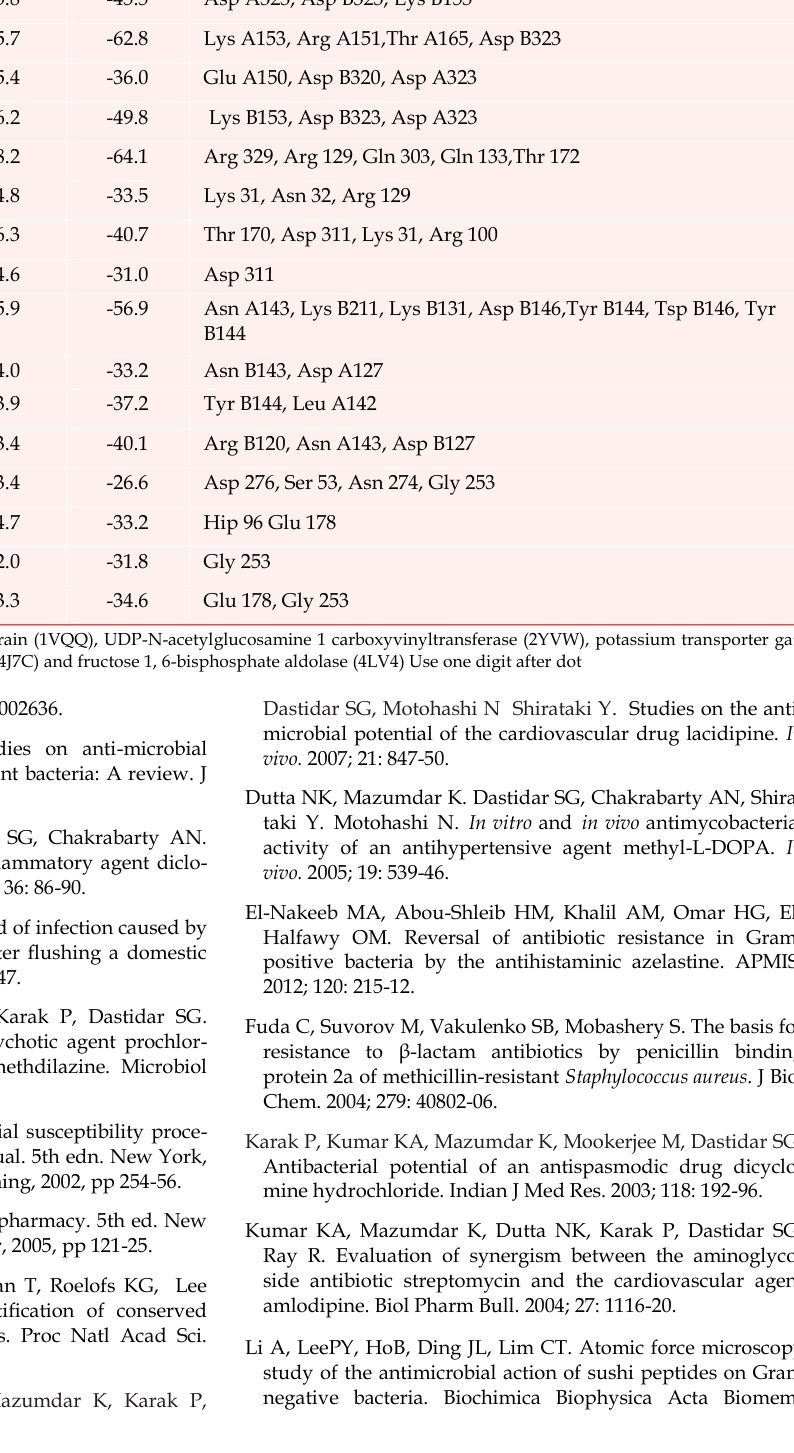
Interaction with H-bond side chain and